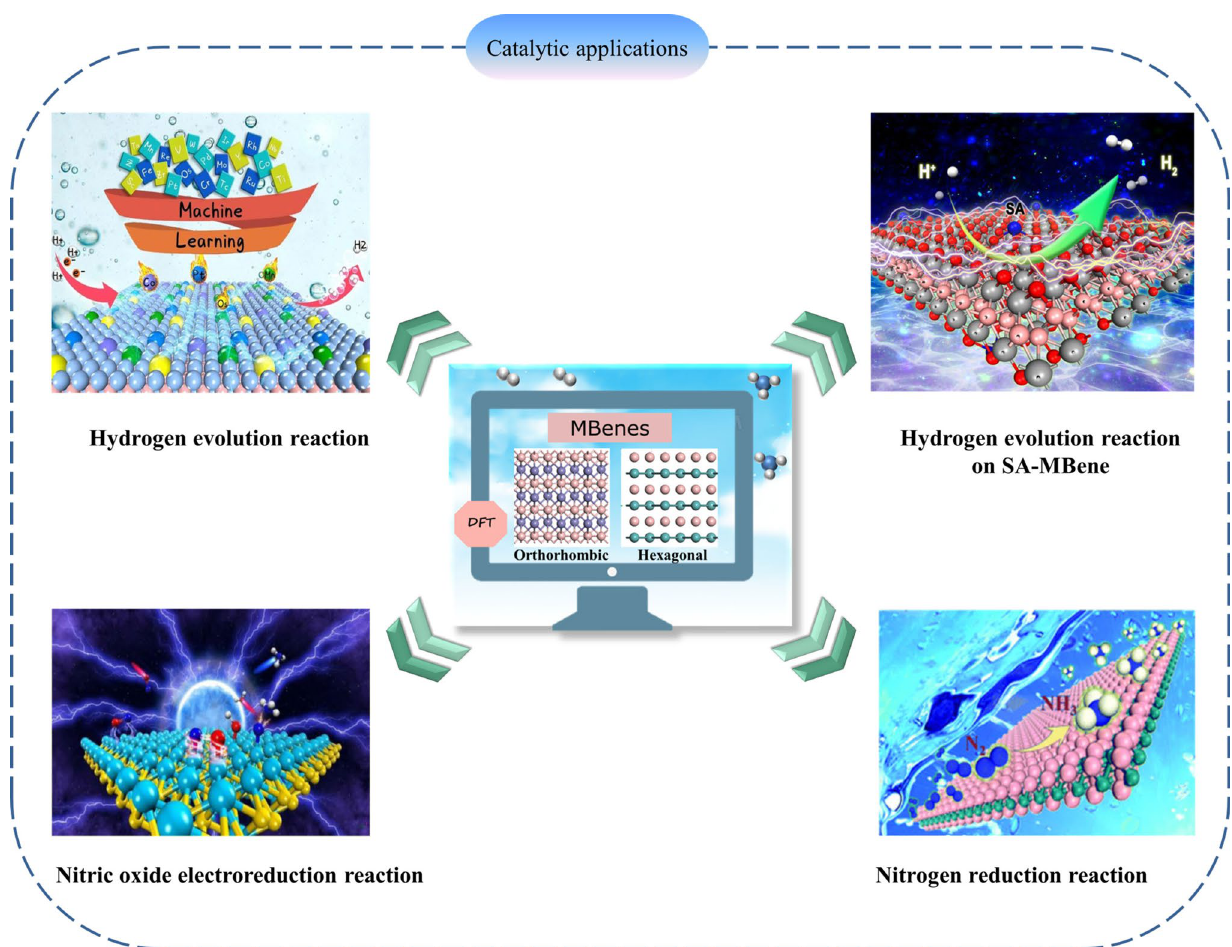
Fig. 8 Applications of MBene as catalyst. Reproduced with permission from Refs.